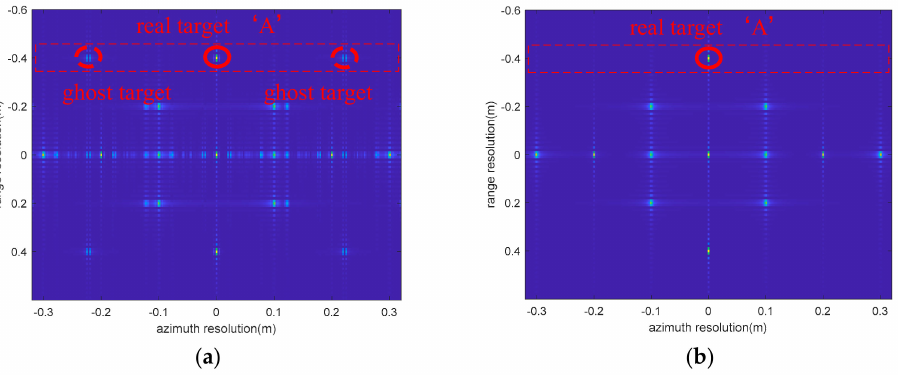
Figure 15. Imaging results without and with compensation under condition 3. ( a ) Without compen- sation and ( b ) with